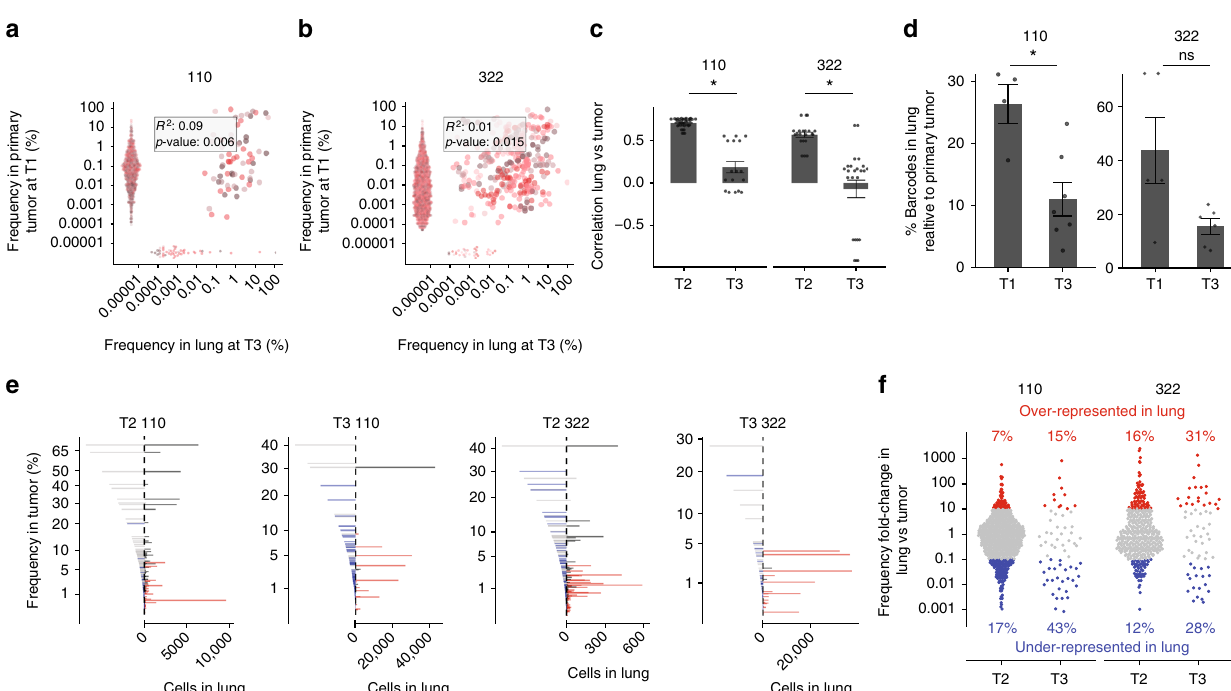
Fig. 4 Characteristics of metastatic ‘ seeder ’ clones after tumor resection. Clonal relationships between resected primary tumor at T1 vs. metastatic lung disease at T3 in a PDX-110 and b PDX-322. Each color represents the clones from one mouse of a total of seven mice for PDX-110 from two independent experiments, n = 9 mice for PDX-322 from three independent experiments. Inset gives adjusted R 2 and p -values using the F -test for linear regression on log-transformed frequencies of barcodes detected in both tissues. c Correlation of clonal relationship between indicated organs based on a and b between distal tissues at T3 compared to resected primary tumor at T1. Data represent 20 mice for PDX-110 from two independent experiments and 23 mice for PDX-322 from four independent experiments (mean ± SEM). d Change in the proportion of barcodes detected in lung prior to (T1) and after (T3) tumor resection in the indicated PDX (mean ± SEM). e Visualization of the clonal frequency of barcodes in primary tumor by bar length (left side of dotted line) and ordered by frequency along the y -axis (represented on square-root scale to highlight dominant clones), with the corresponding number of cells of the same clone estimated in lungs (right sides of dotted line). Blue bars indicate clones that were under-represented (<10-fold compared to frequency in primary tumor), and red bars indicate over-represented in lung (>10-fold compared to frequency in primary tumor). f Ratio of frequency in primary tumor compared to lung for all barcodes from all mice detected in both organs, with a cut-off for clones 10-fold over-represented (red) and 10-fold under- represented (blue), with indicated proportions of red and blue barcoded clones when tumor was present and large (T2), and at late metastatic disease after tumor resection